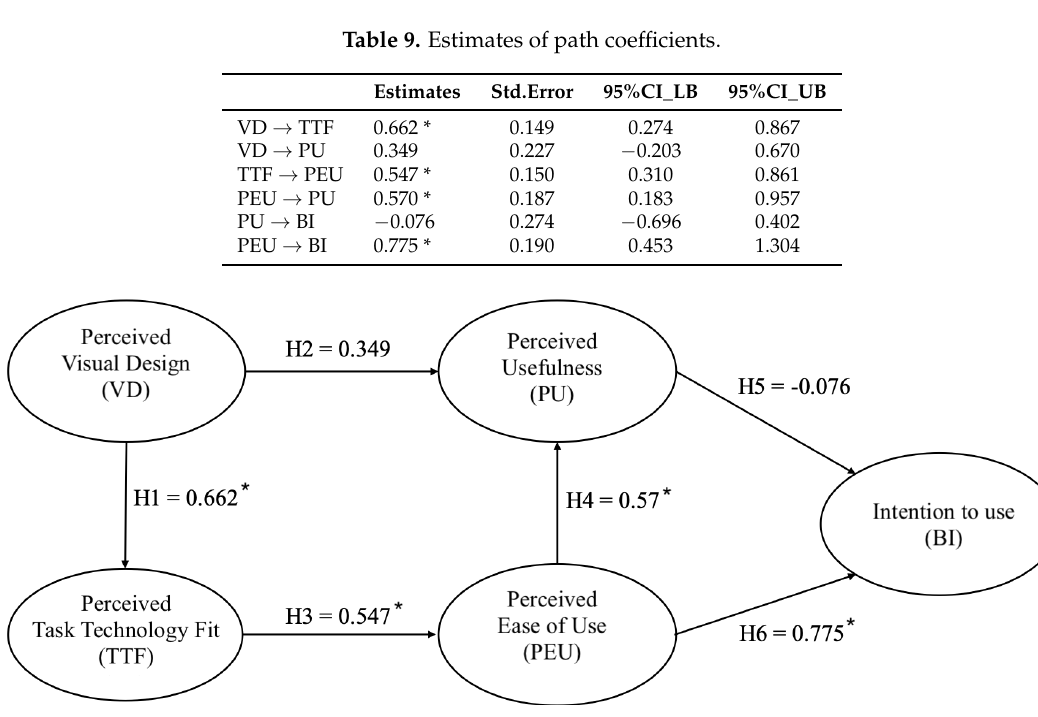
Figure 7. Path coefficient research model